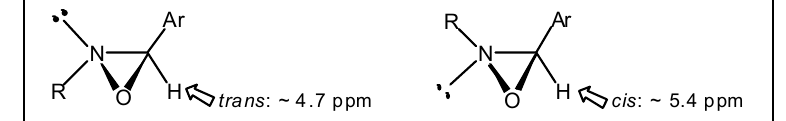
Figure 1. Chemical shifts of protons in cis and trans oxaziridines [27].